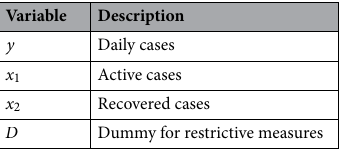
Table 3. Descriptions of the variables for the daily cases model.